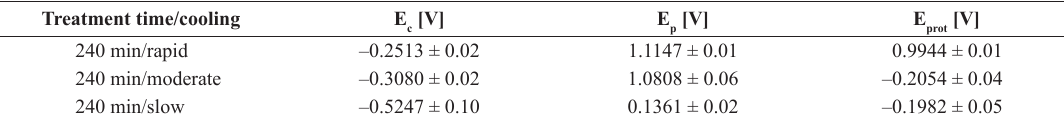
Table 1. Electrochemical parameters of 2205 DSS solution-treated, obtained in synthetic marine solution (60,000 mg/L de Cl-). Treatment time/cooling